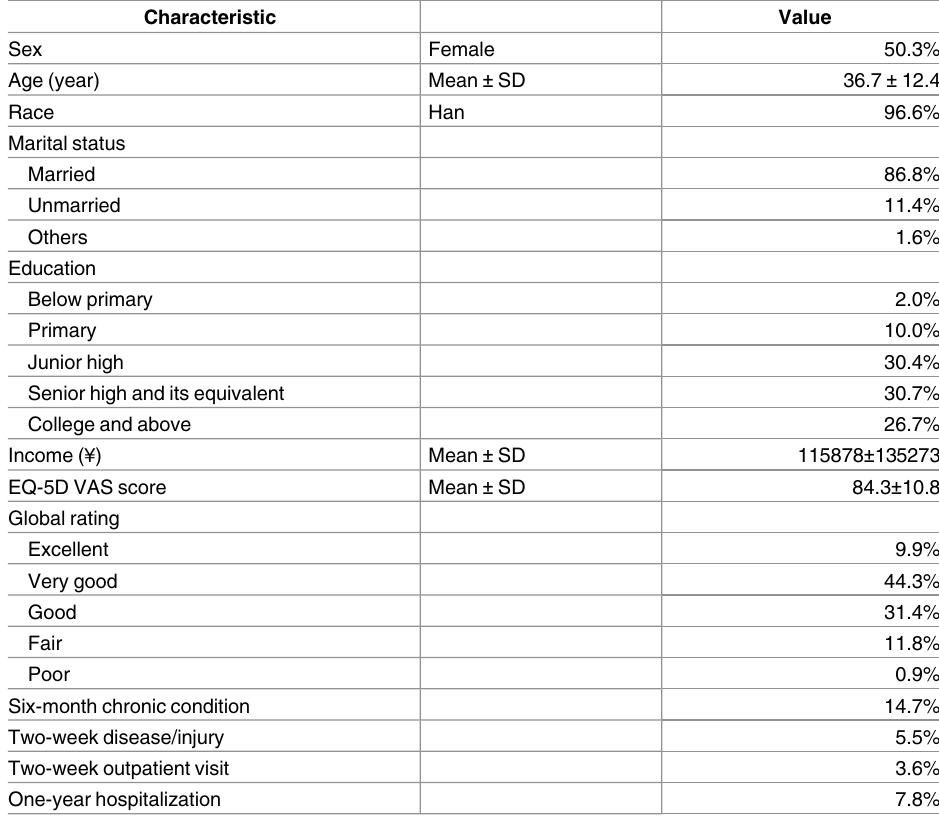
Table 1. Characteristics of the respondents (n =